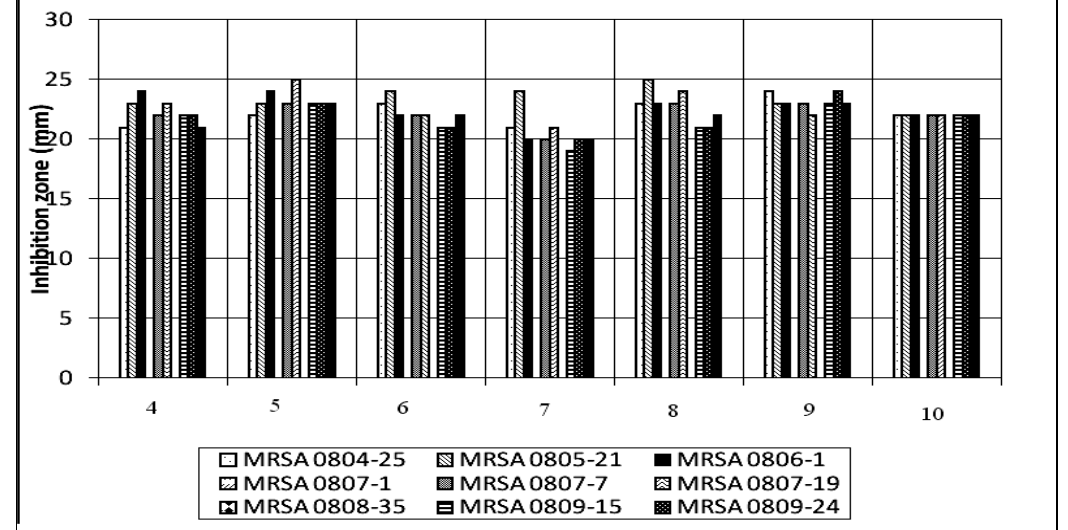
Figure 2. Histogram for the 10 MRSA clinical strains of Schiff-base